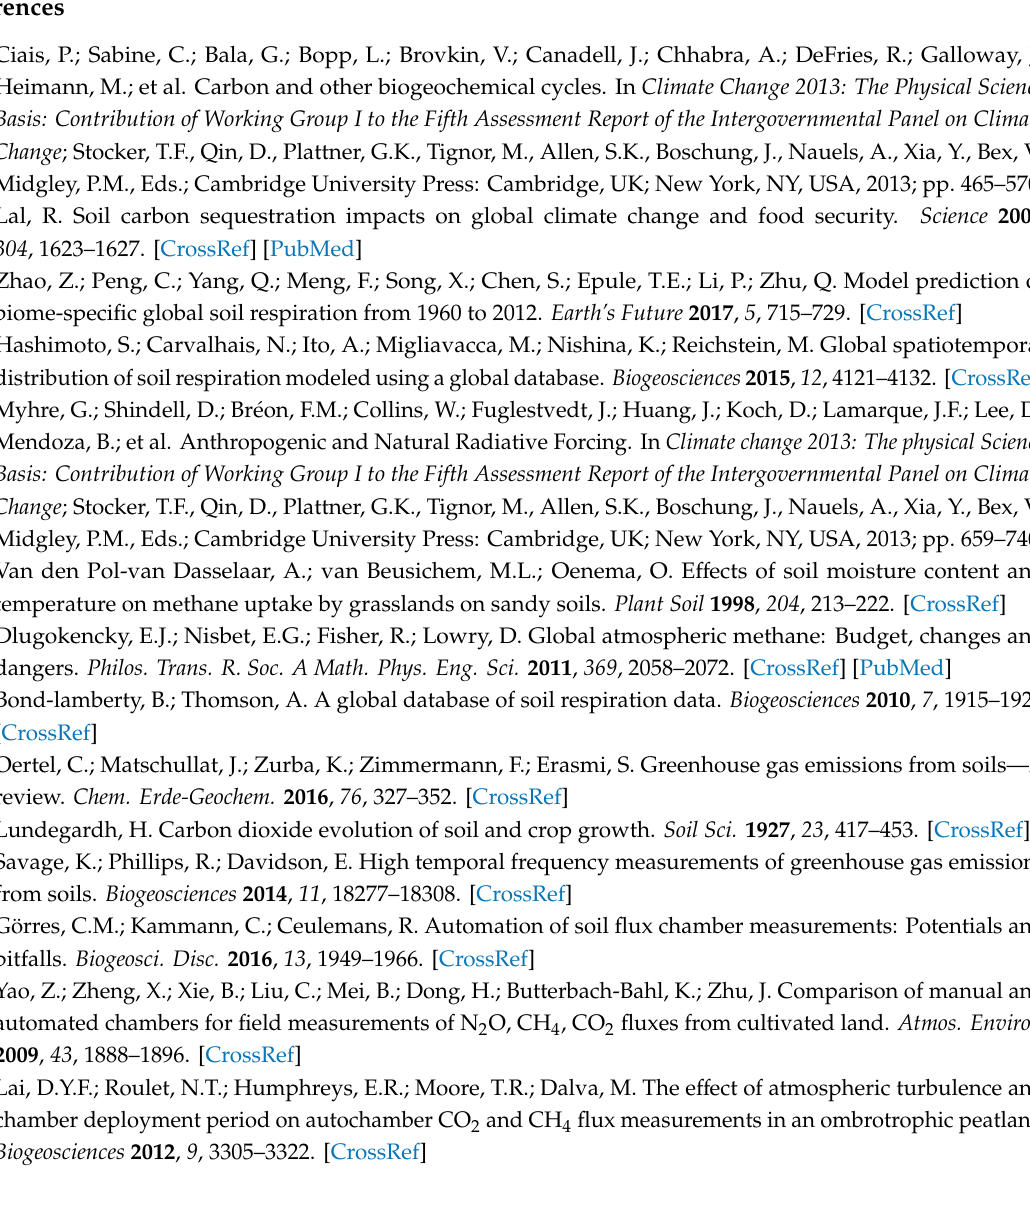
method AFII, Table S3: Equations for annual CH 4 flux simulation and the predictive performance using method AFI, Table S4: Equations for annual CH 4 flux simulation and the predictive performance using method